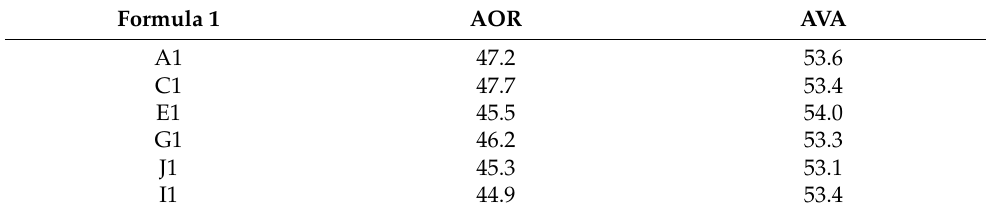
Table 7. The flow ability of powders prepared by Formula 1.